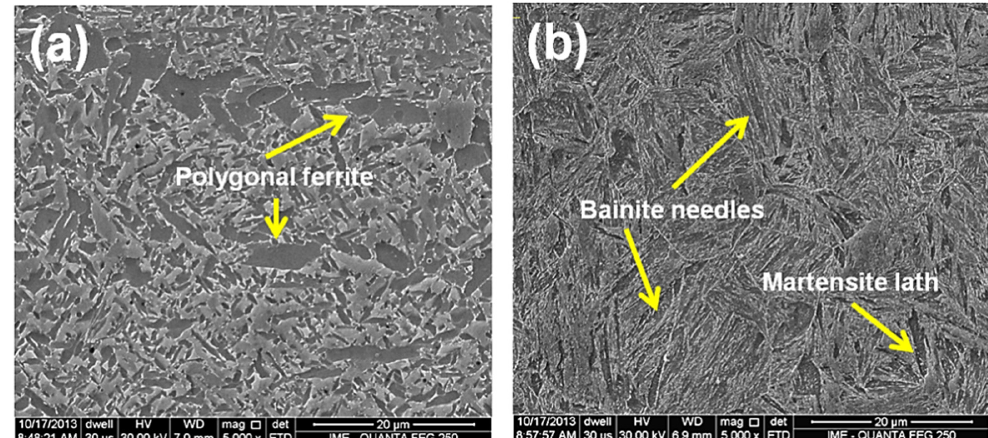
Figure 10 . SEM micrographs of the lower heat input welded joint, in the regions ( a ) FZ and ( b ) HAZ.